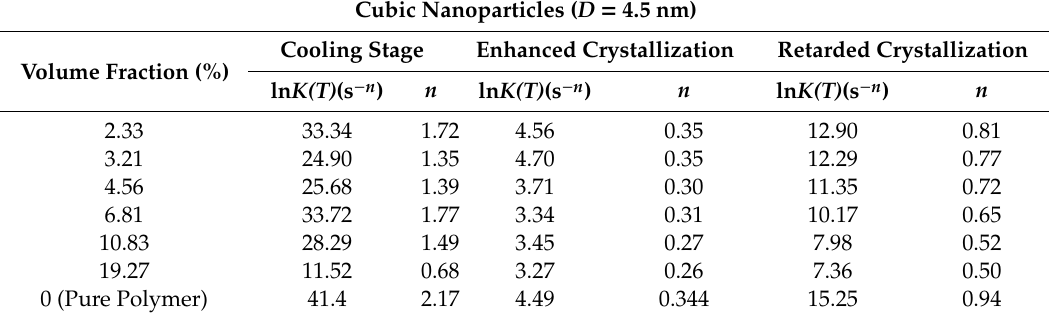
Figure 3. The Avrami plots for the crystallization kinetics data in Figure 2a for pure polymer and nanocomposite systems made from 4.5 nm particles at various volume fractions. The figure shows the growth rate and crossover from enhanced crystallization to retarded crystallization regimes. Table 1. The Avrami growth function and exponent extracted from the linear fit to crystallization regimes shown in the Avrami plots in Figure 3.